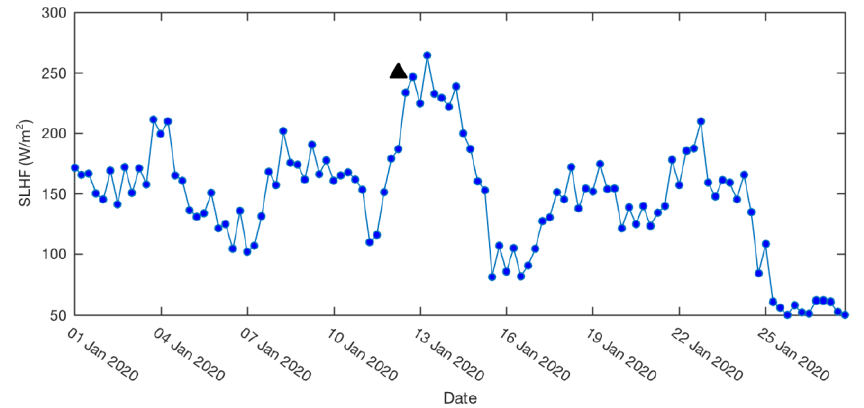
Figure 18. Temporal variations of 4-time daily SLHF over the ocean located on the southwest of the Taal volcano before and after the eruption. The black upward triangle shows the time of the volcanic eruption.